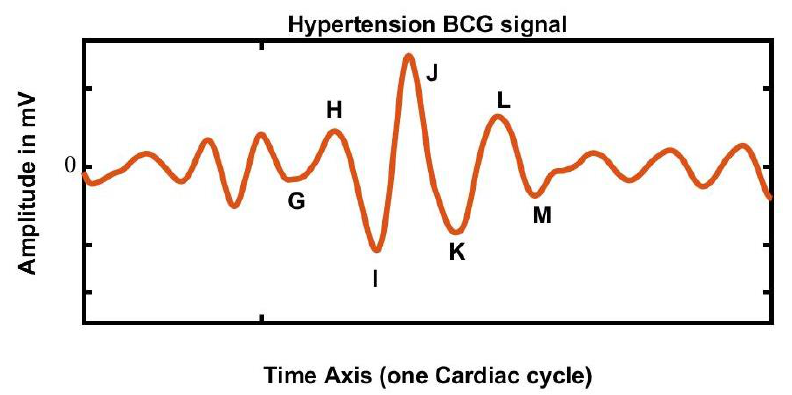
Figure 3. Normal (HC) BCG signal obtained from the database. The details of the G, H, I, J, K, L, and M waves of the BCG signal are mentioned in Table 1.